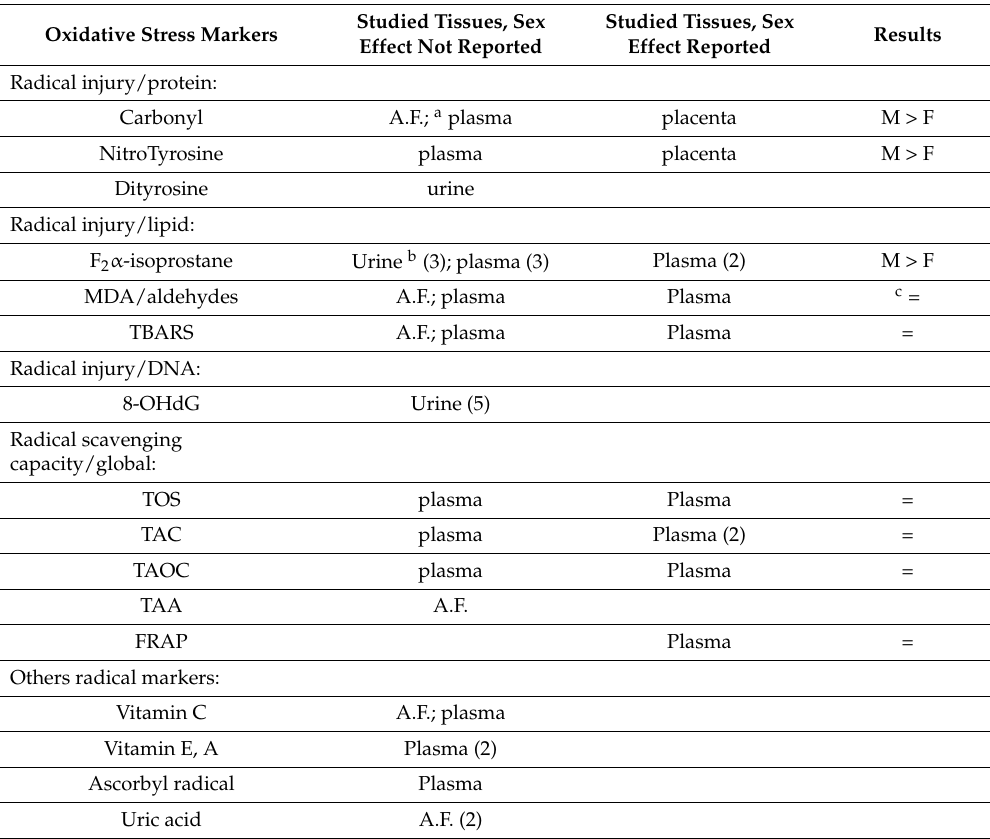
Table 2. Studied tissues in function of the type of oxidative stress markers (designed from Table 1). Oxidative Stress